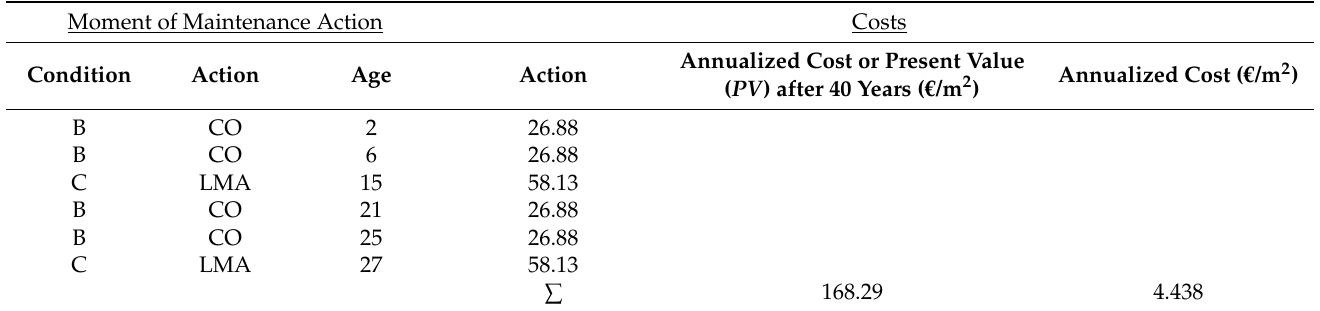
Table 8. Annualized cost of maintenance for the third maintenance strategy (MS3), considering a time horizon of 40